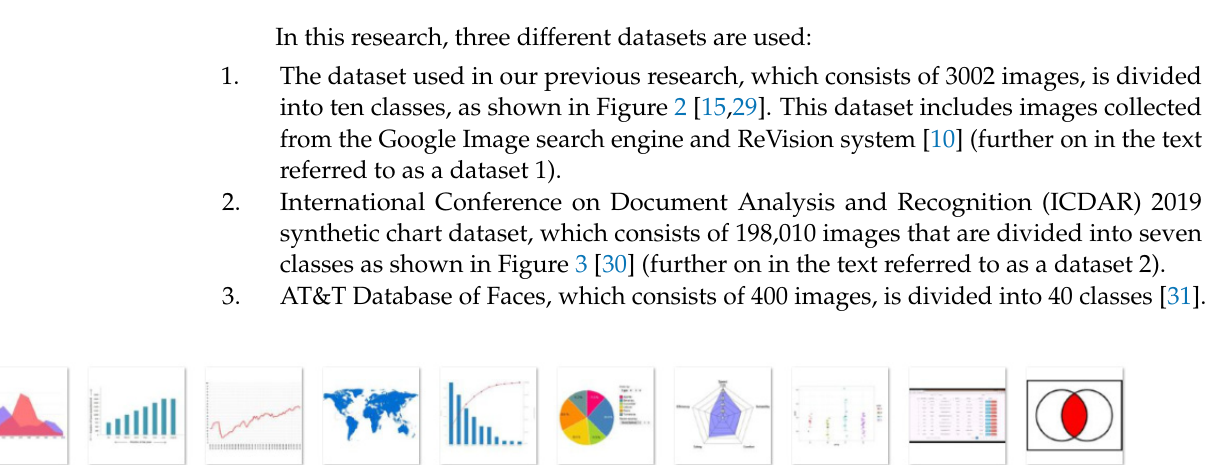
Figure 1. Image pre-processing algorithm.